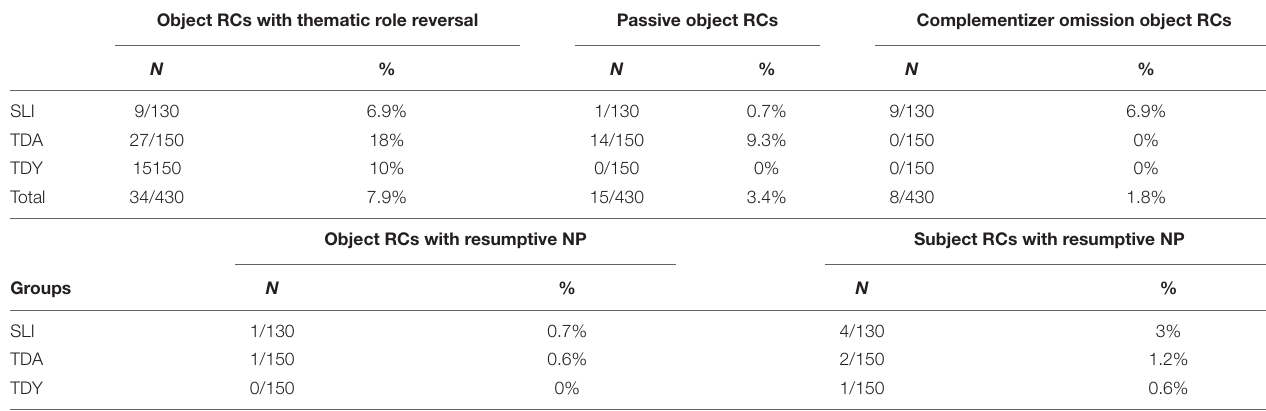
TABLE 5 | Numbers (N), percentage (%) (other responses/all responses) of other responses in each group. Groups Simple